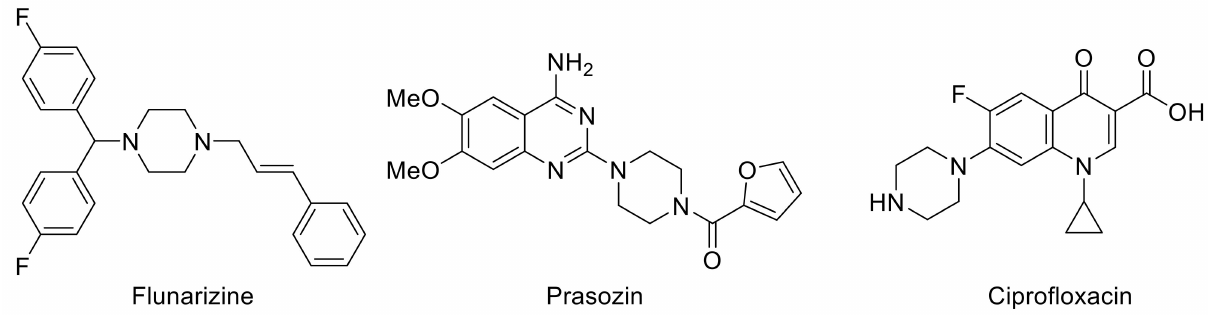
Figure 1. Structures of some common piperazine-based drugs.